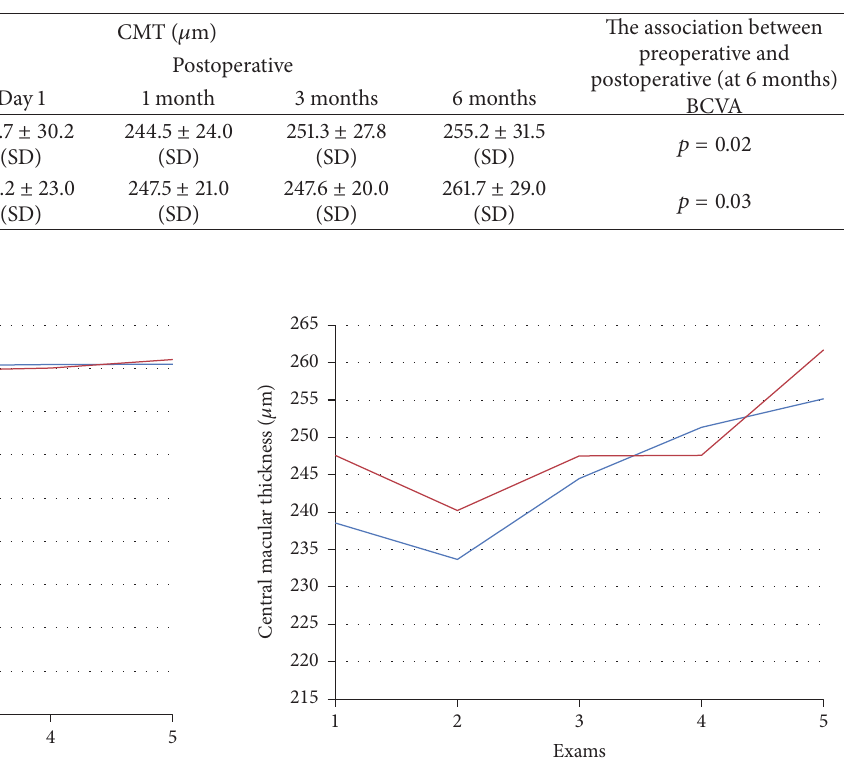
Table 3: Central macular thickness (CMT) in 𝜇 m at optical coherence tomography preoperatively and at all follow-ups.